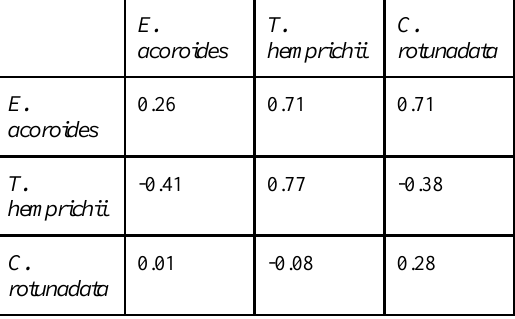
Table 1. Table of coefficients for the Bongolan